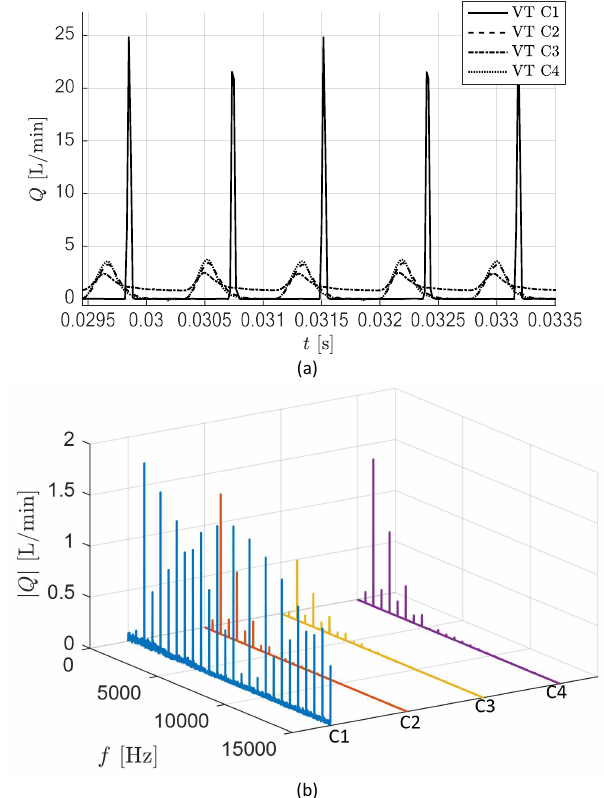
Figure 26: Plots of four pressurization ripple solutions: for Ref EGP, 2000 RPM, 200 Bar, VT circuit, for Figure 26. Plots of four pressurization ripple solutions: for the reference gear pump at 2000 RPM, four different setups, from C1 to C4. Ripples are plotted in (a) time domain and (b) frequency domain up to 10,000 Hz. 200 bar. The VT circuit is assumed for four different setups, from C1 to C4. Ripples are plotted in ( a ) time domain and ( b ) frequency domain up to 10,000